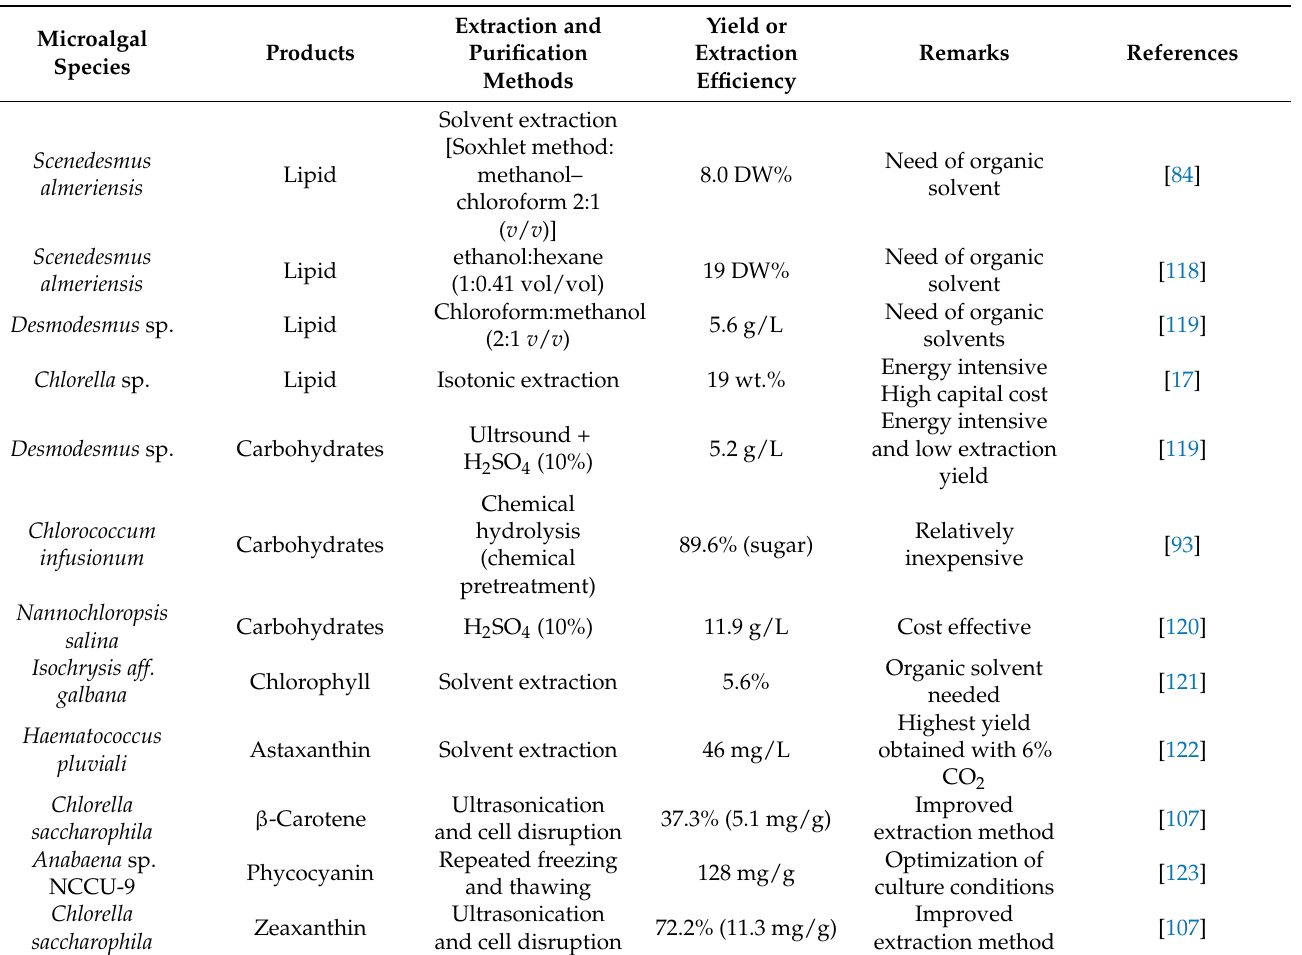
Table 3. Microalgal bioproducts